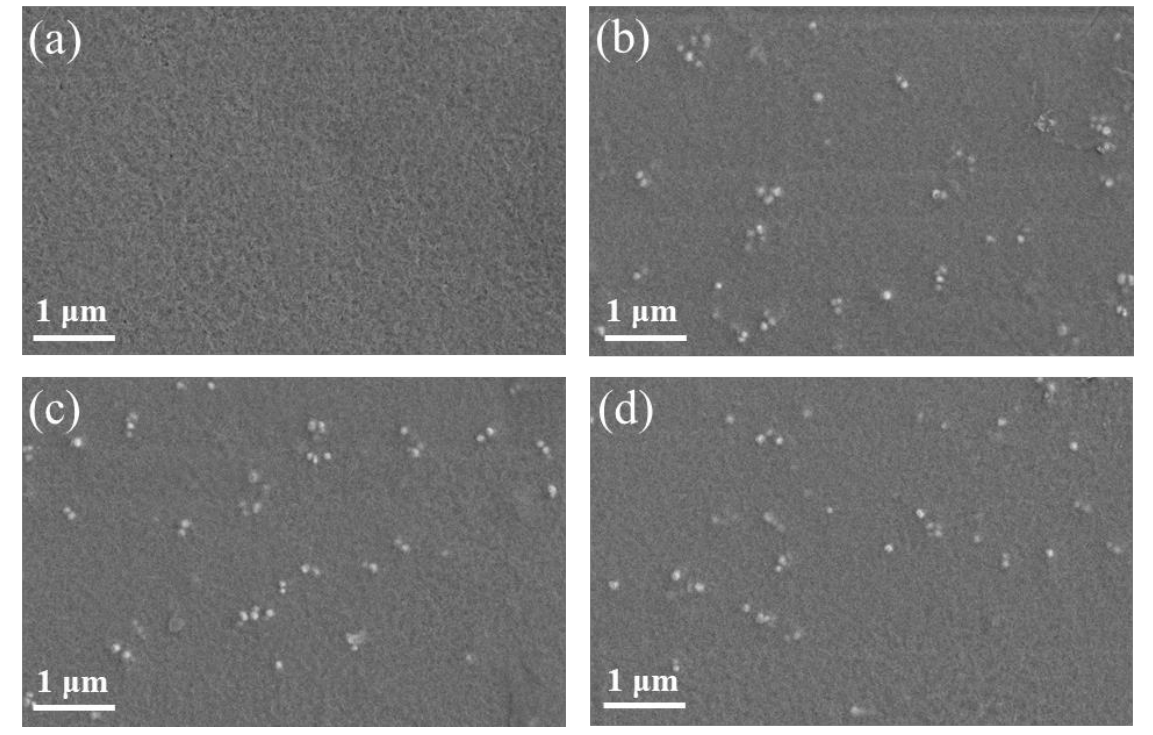
Figure 3. FESEM images of the surfaces of the as-printed films: ( a ) pure PVDF, ( b ) 8 wt% BTO/PVDF, ( c ) 8 wt% PDA- BTO/PVDF and ( d ) 8 wt% PFD-BTO/PVDF.